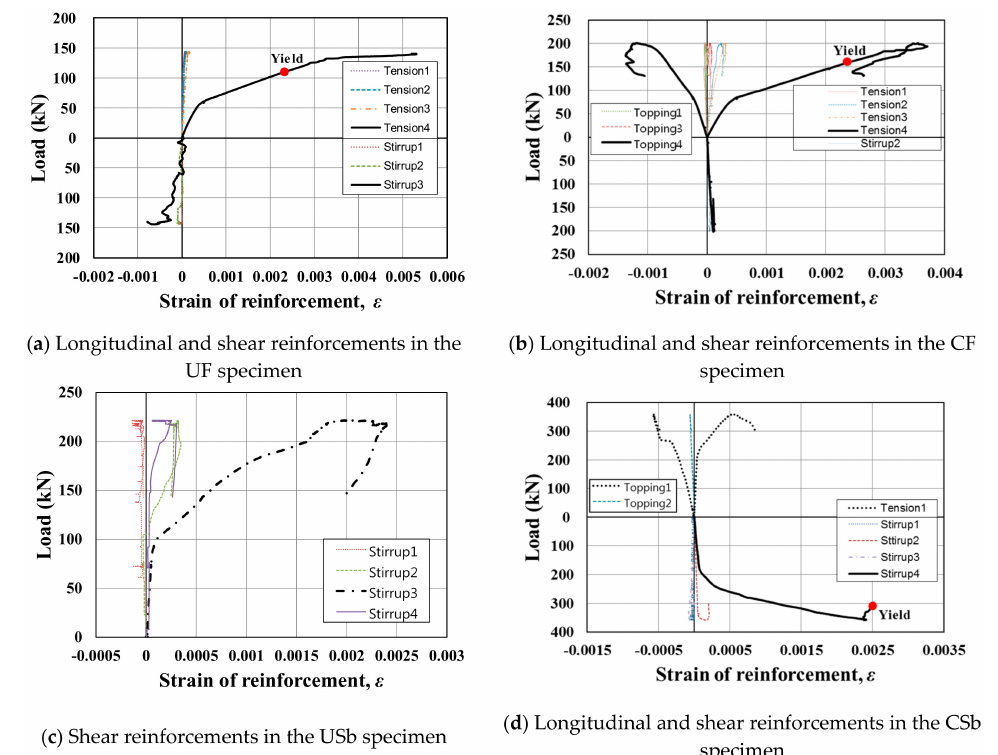
Figure 14. Measured strains from the longitudinal and shear reinforcements.